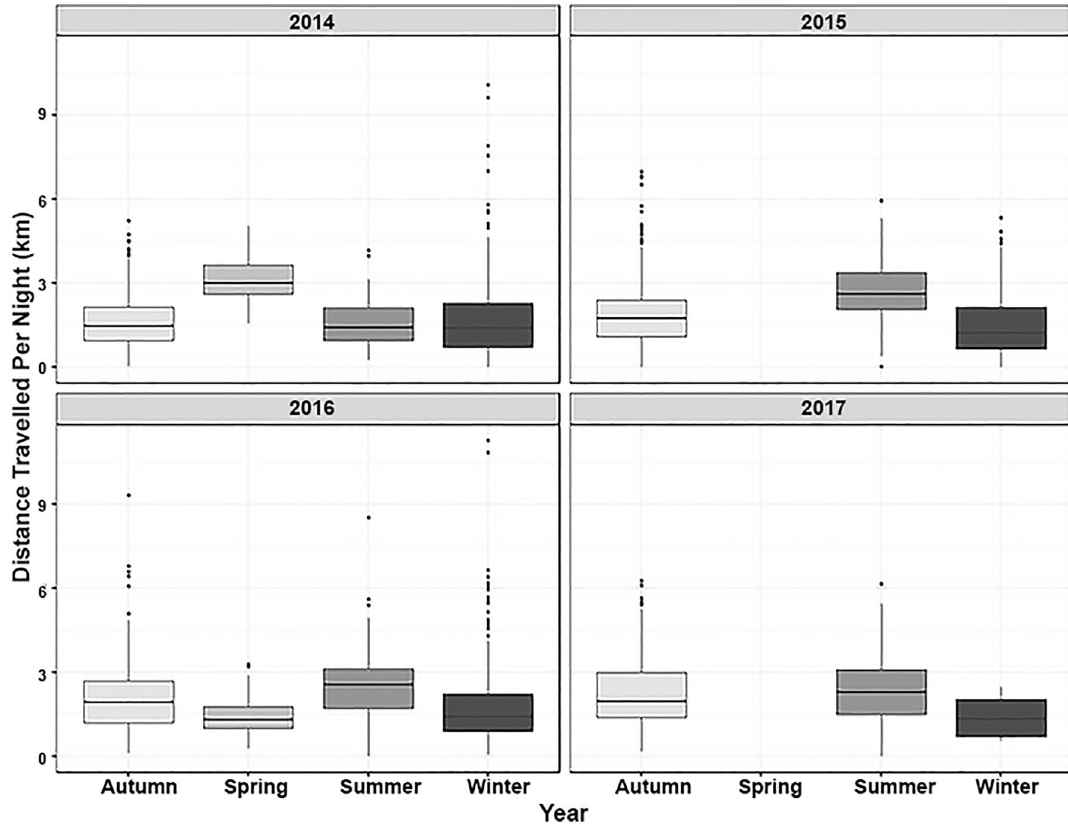
Figure 7. GPS distance travelled per night across seasons for Summer, Autumn, Winter and Spring (where data are available) each year. The median is shown as a black horizontal line, with upper and lower quartiles (mean point between maximum/minimum data points and the median) at the top/bottom of the bar. Whiskers (vertical black lines) denote lower and upper 25% of data values. Black points denote outliers (data points 1.5 times lower/higher than the interquartile